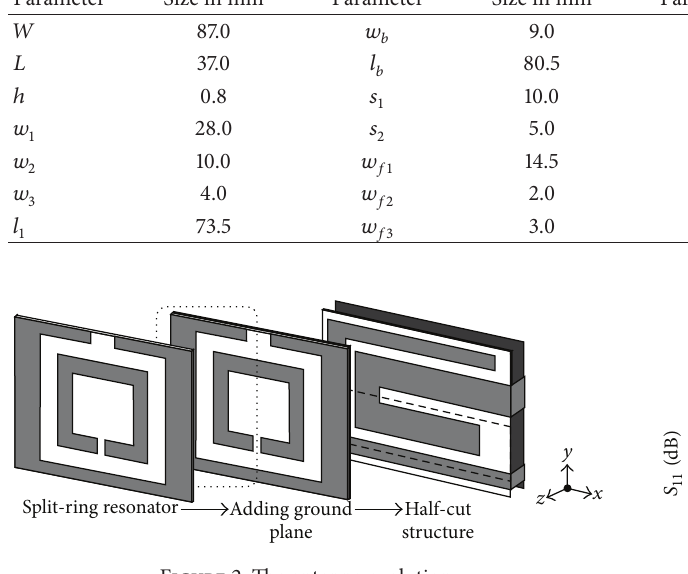
Figure 2: The antenna evolution.